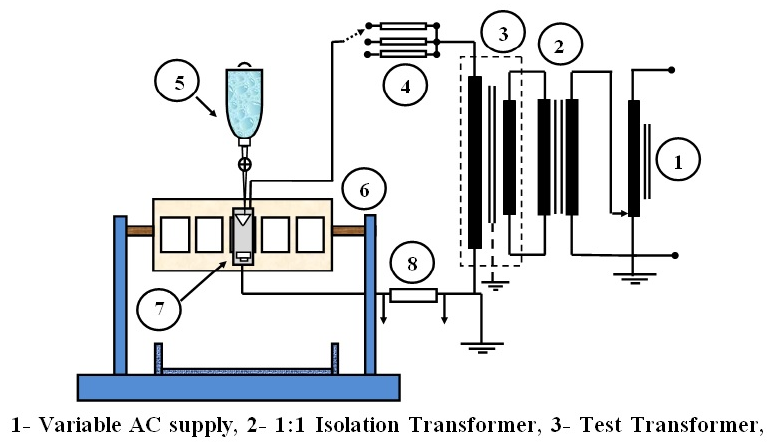
Figure 2. Experimental setup for the inclined plane test.